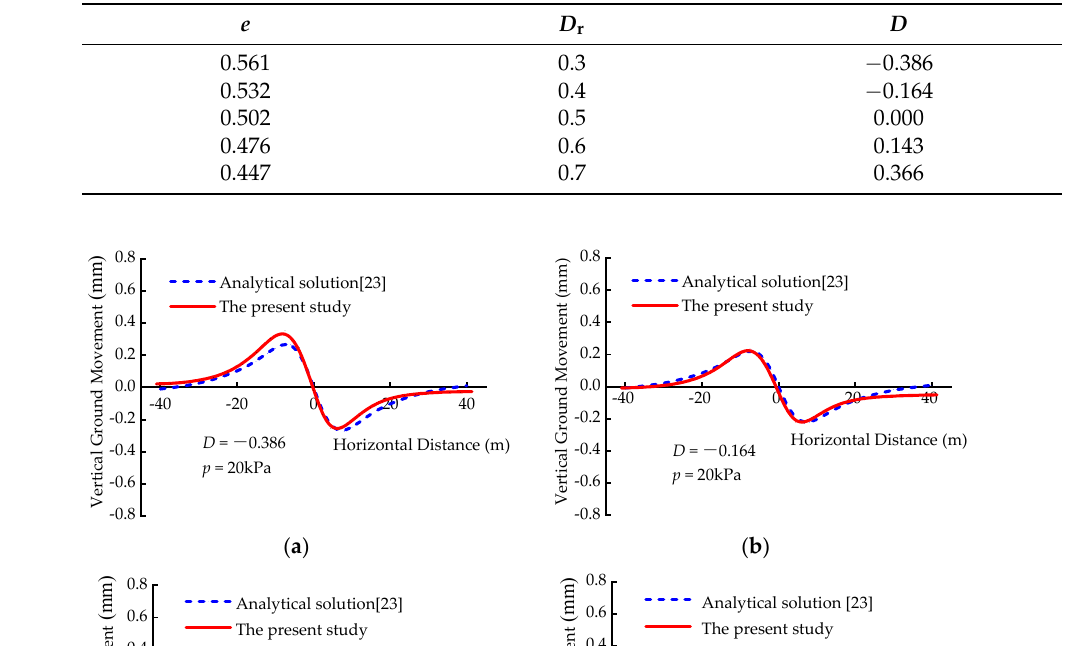
Table 11. Soil disturbance degree in different cases.